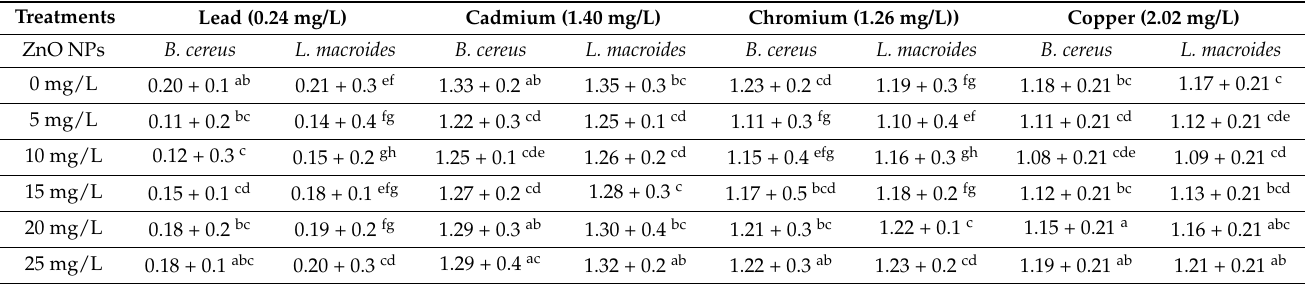
Table 1. Synergistic effect of the bacterial strains ( B. cereus and L. macroides ) and ZnO NPs (5, 10, 15, 20 and 25 mg/L) on the polluted water sample collected from Hayatabad Industrial Estate (HIE), Pakistan.